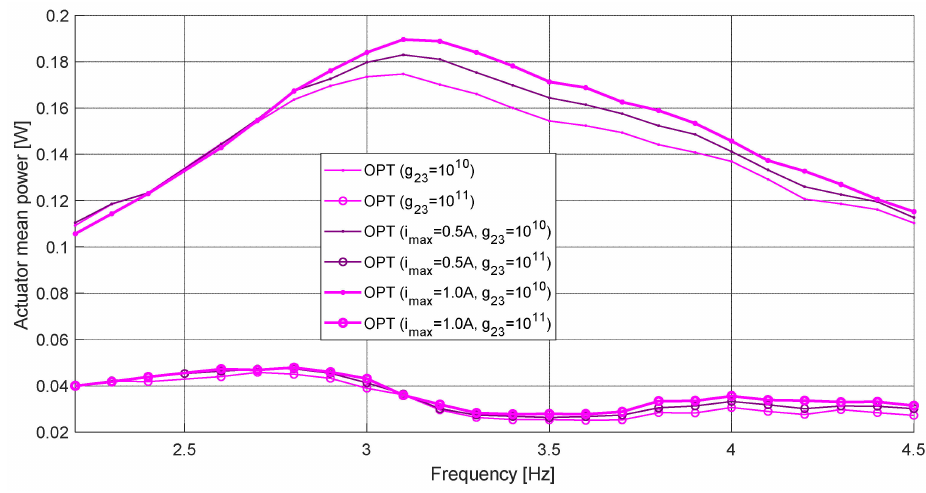
Figure 17. The mean actuator power frequency characteristics: OPT for different i max and g 23 values, and F nom = 12.5